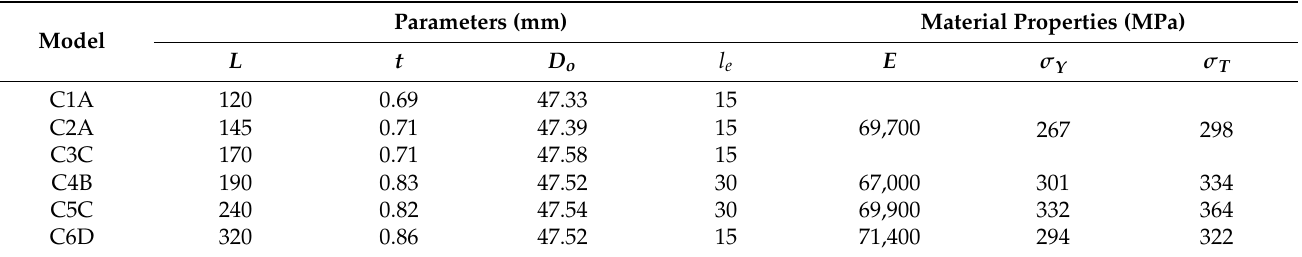
Table 2. Geometrical and material information (reproduced from [19], with permission from Pukyong National University,